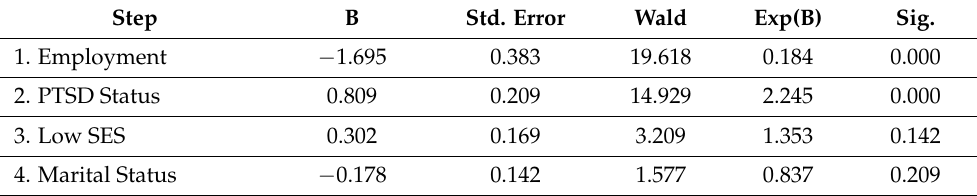
Table 1. Total logistic-regression model for prediction of hypertension incidence. Step B Std. Error Wald Exp(B)